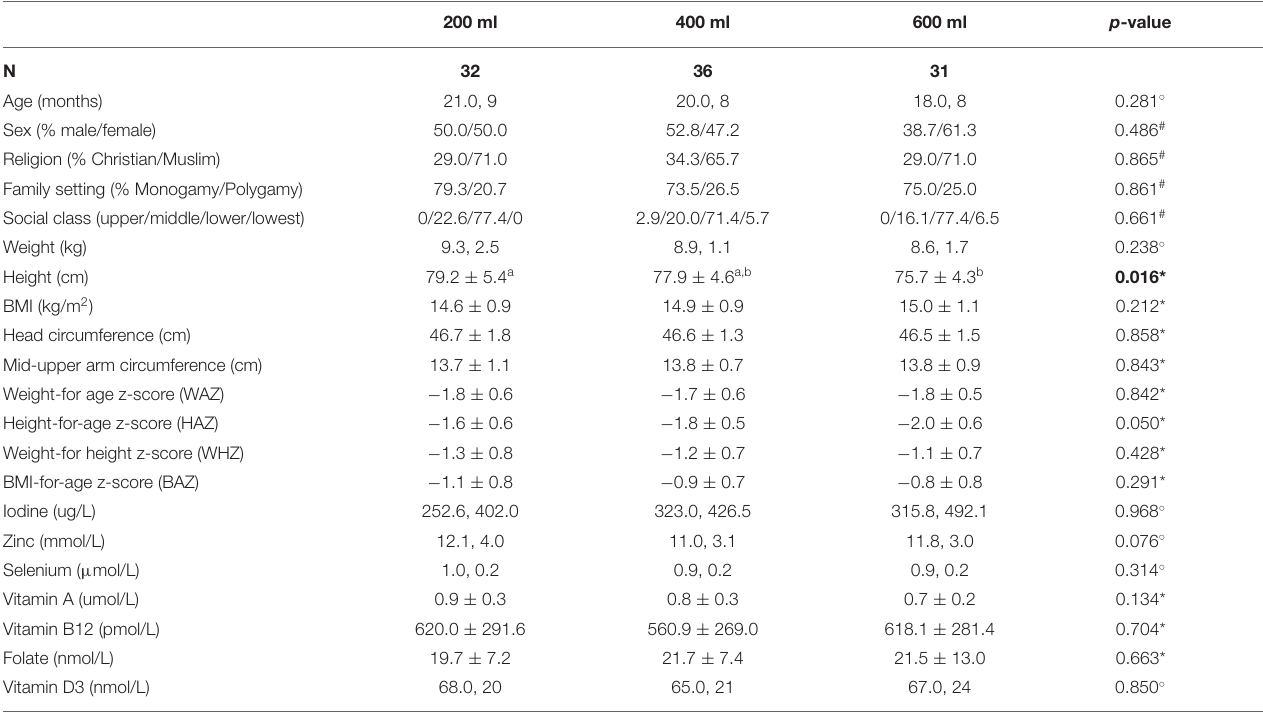
TABLE 2 | Baseline characteristics of the modified PP population, a study in which Nigerian toddlers with malnutrition were provided with a fortified dairy-based drink in daily amounts of 200, 400 or 600ml, during 6 months (presented as mean ± SD or median, IQR).